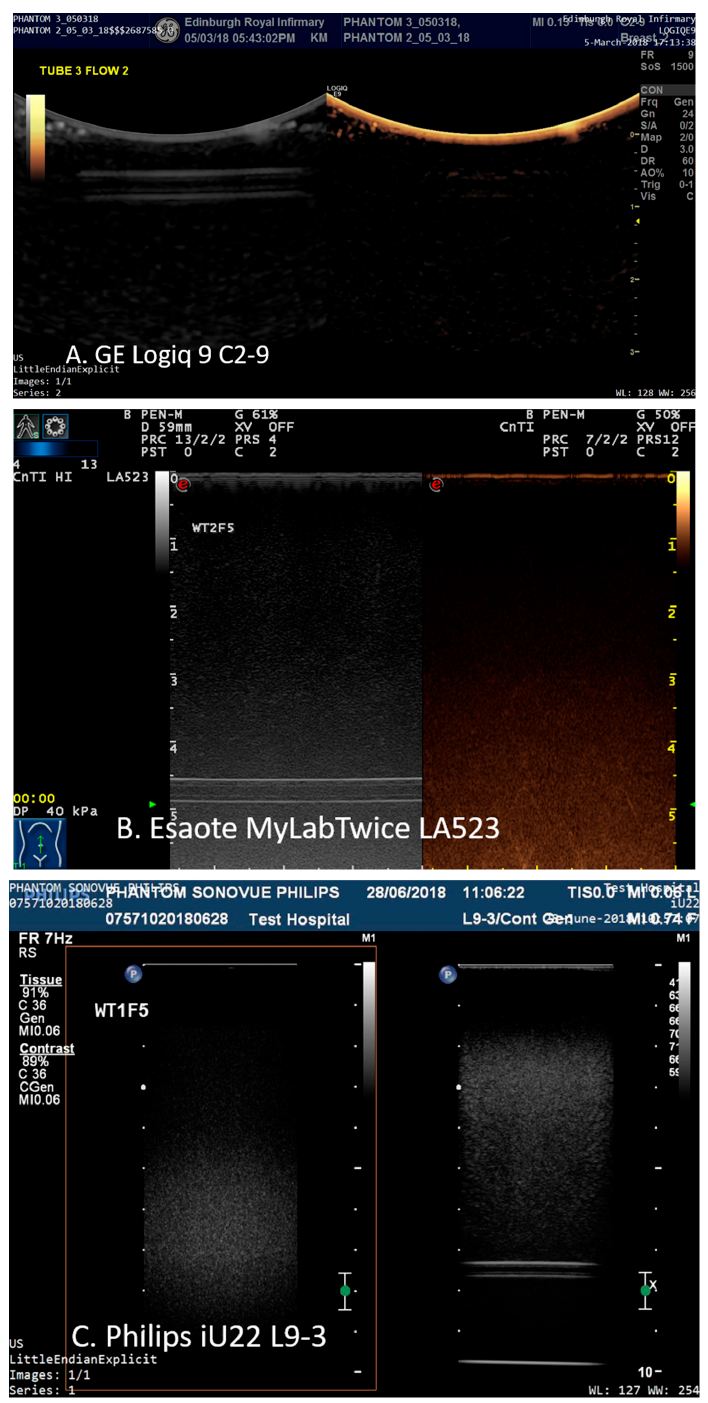
Figure 2. Images acquired from 1.6 mm tubing filled with water at ( A ) 1 cm depth imaged using the GE Logiq9 C2-9 transducer; ( B ) 5 cm depth imaged using an Esaote MyLab Twice LA523 and ( C ) 8 cm depth using a Philips iU22